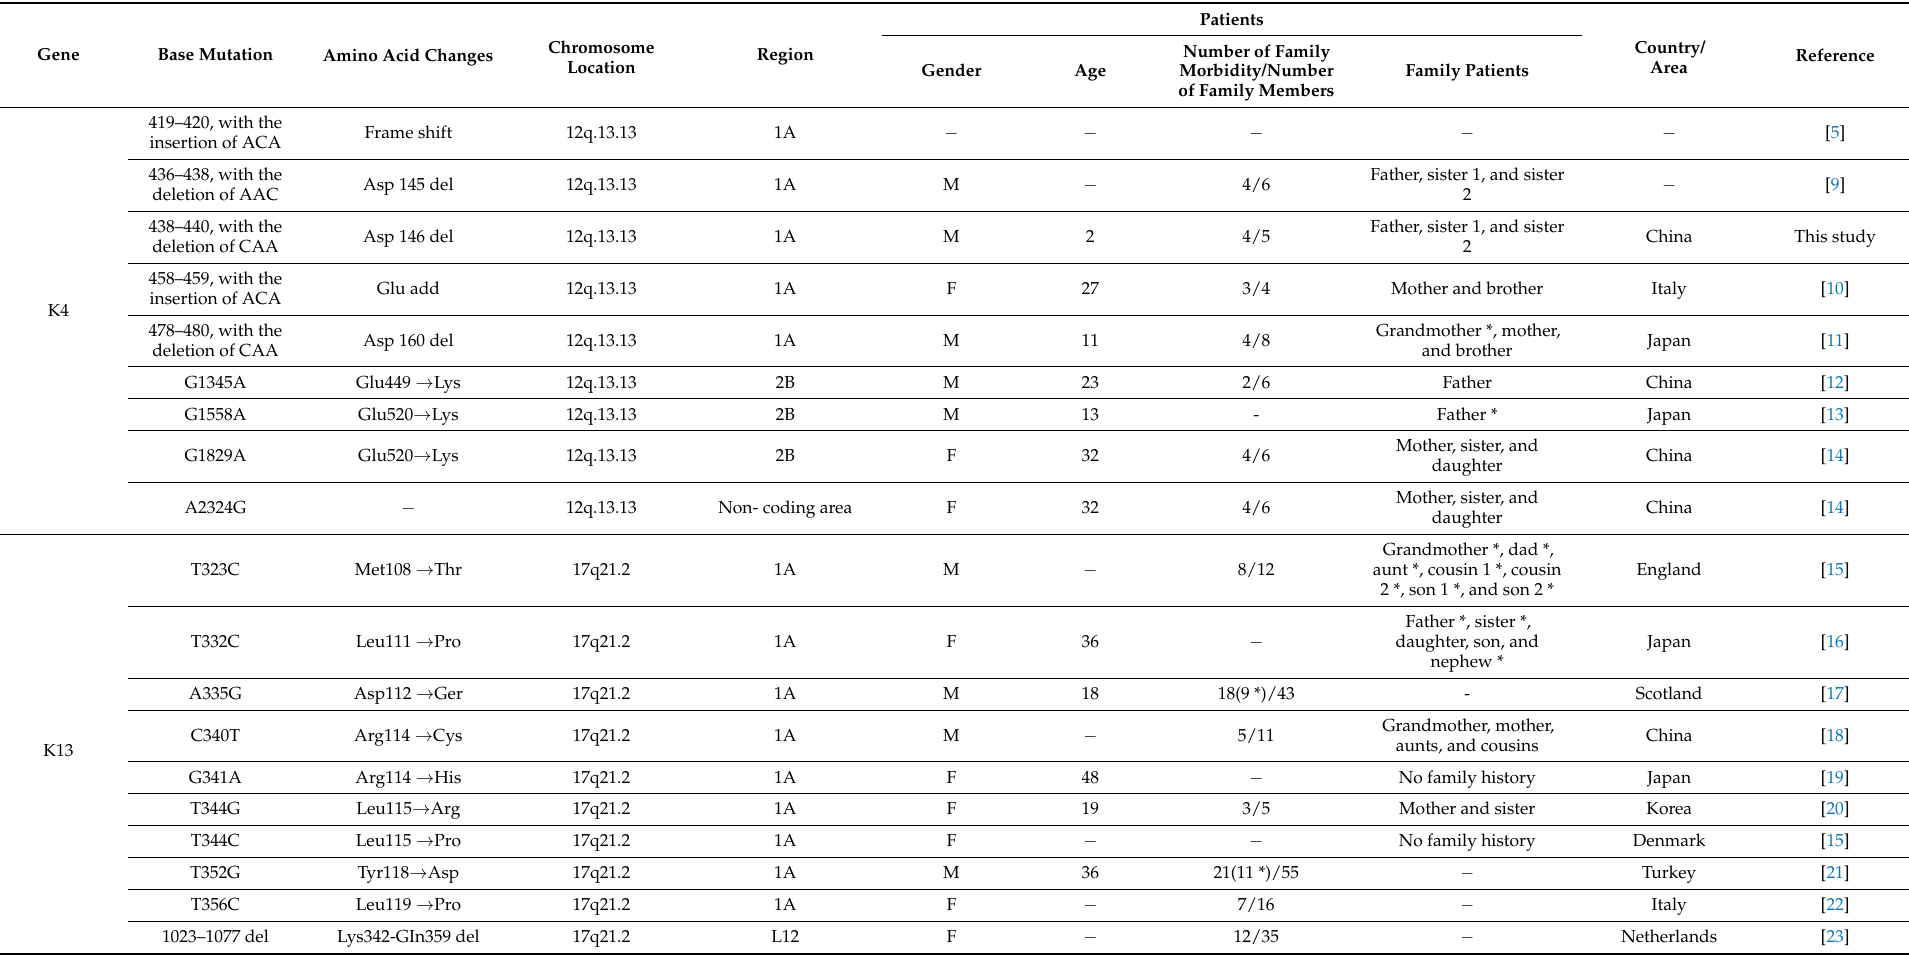
Table 1. Types of mutations of the K4 and K13 genes in patients with